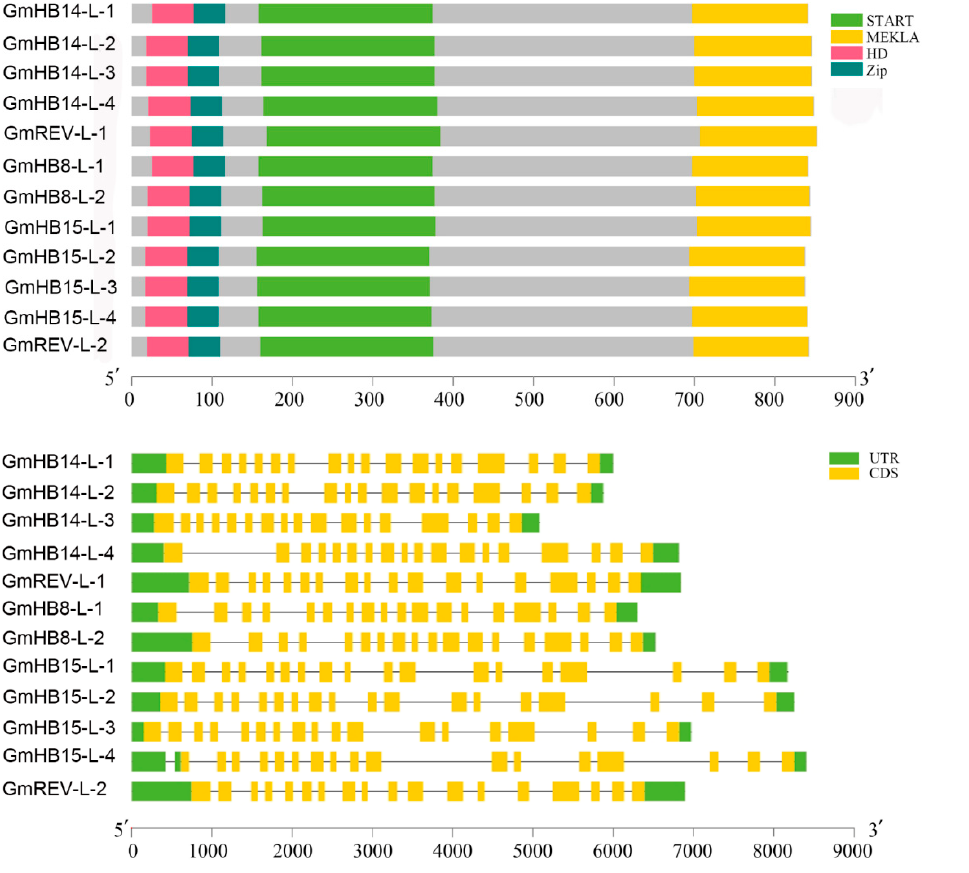
Figure 2. Gene structure, conserved domain, and motif identification. ( a ) Phylogenetic relationships and protein domain prediction of HD-Zip III from soybean. The lengths of the proteins and domains can be estimated by using the scale at the bottom. ( b ) The gene structures of the 12 GmHD-Zip III genes. Exons and introns are shown as green and yellow boxes, respectively. Gene structures are shown in the right panel.